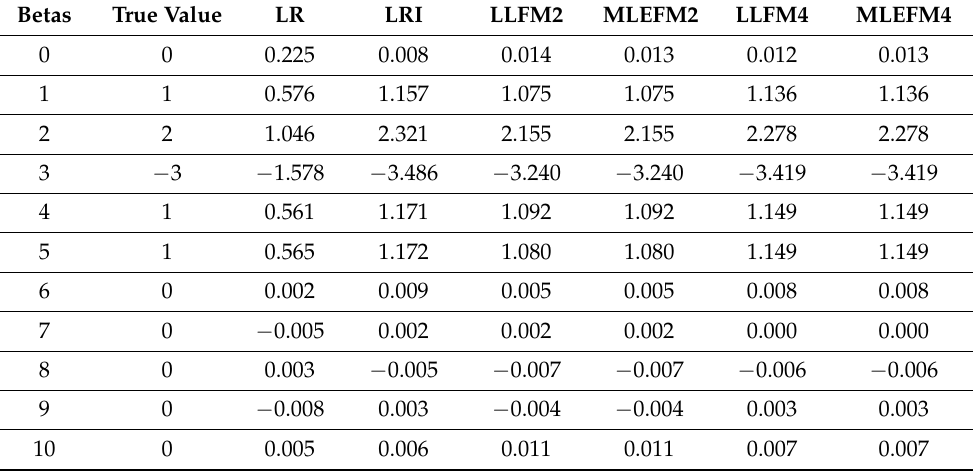
Table 2. Average of predictor coefficient estimates over 200 repetitions for N = 1000 for logistic regression (LR), logistic regression with interaction (LRI), two factor factorisation machine based on logit loss (LLFM2) and maximum likelihood (MLEFM2), and four factorisation machines (LLFM4 and